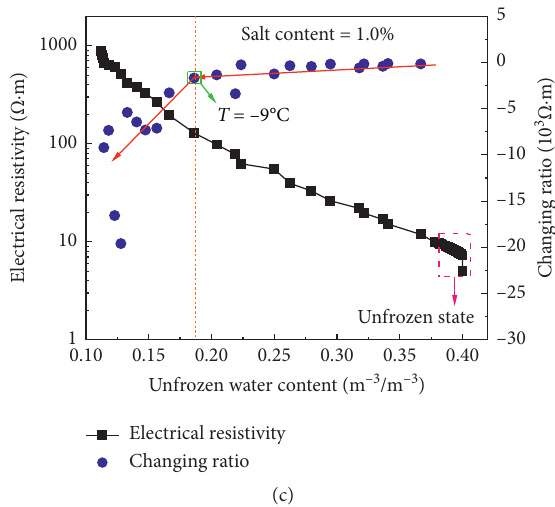
Figure 6: Electrical resistivity and the changing ratio of electrical resistivity varied with unfrozen water content under a freezing state. (a) Without salinity. (b) Salinity of 0.2%. (c) Salinity of